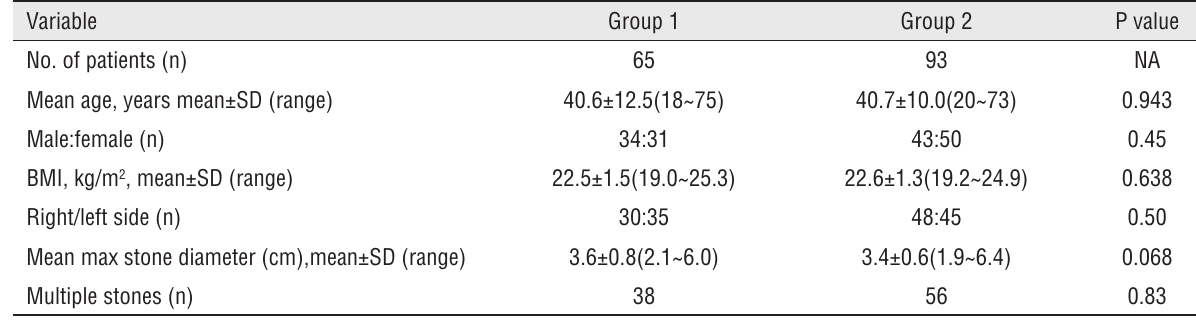
Table 1 - Patient demographics and stone characteristics\operative details and outcomes in the two Groups.